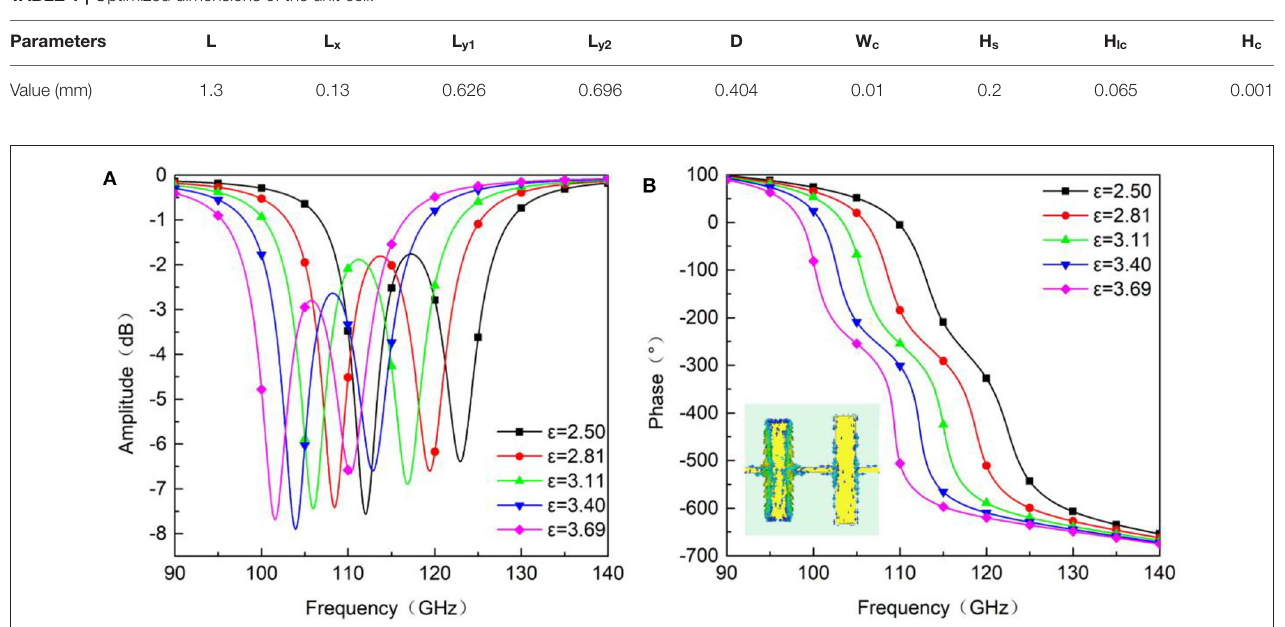
FIGURE 2 | Simulated amplitude (A) and phase shift (B) as a function of frequency for different dielectric permittivities and surface current distribution around the double-dipole.